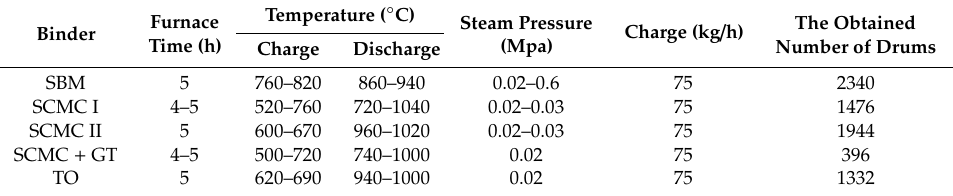
Table 3. Technological parameters of